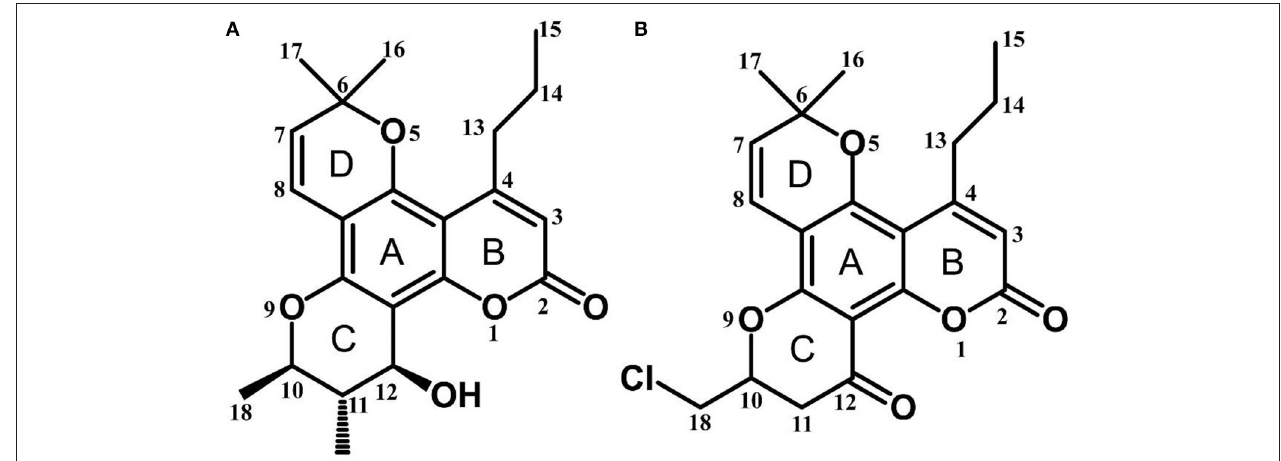
FIGURE 1 | Chemical structures of calanolide A (A) and F18 (B)